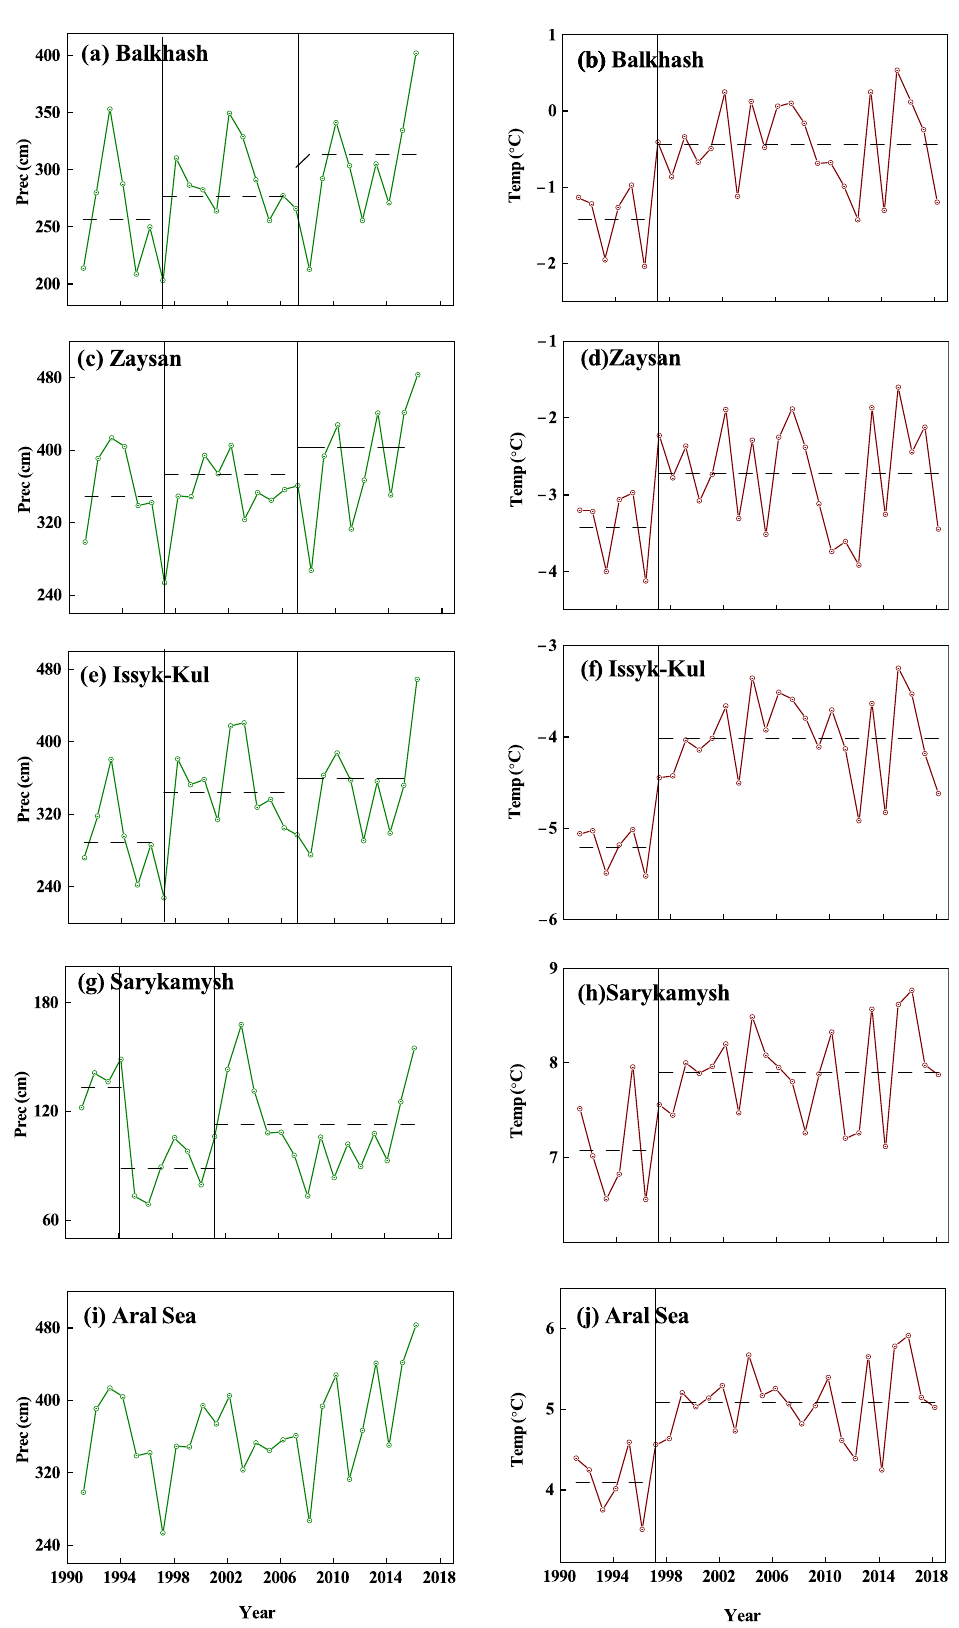
Figure 5. The significant regime shift in time series of precipitation (green line, left panel) and temperature (red line, right panel) over five lakes in Central Asia: vertical lines represent regime shift years and horizontal dash lines represent the mean value of each regime.